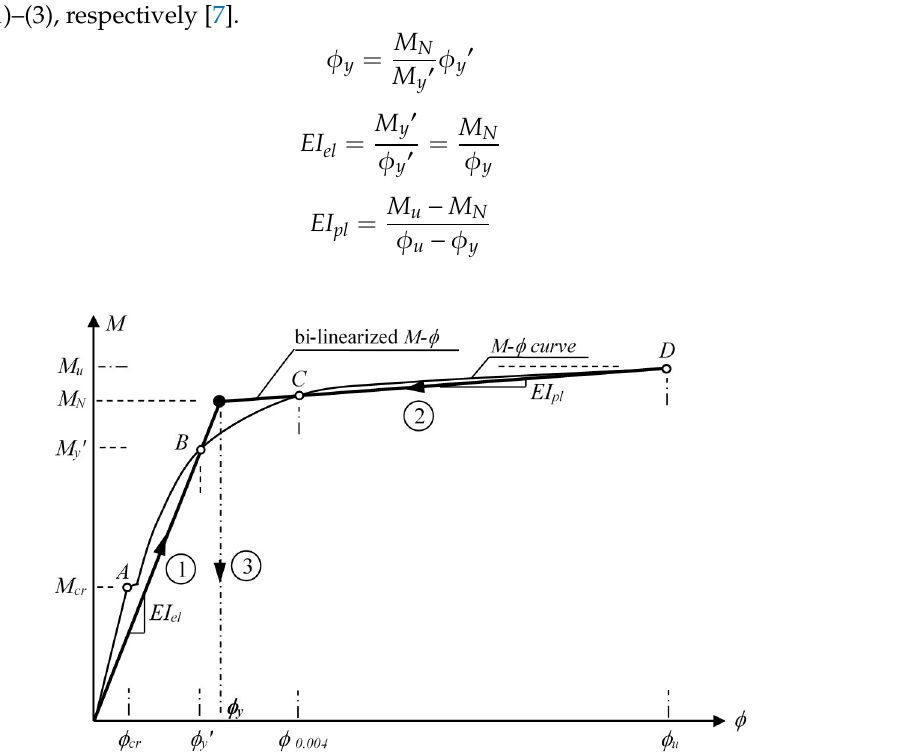
Figure 4. Bi-linearization of a typical moment–curvature response.